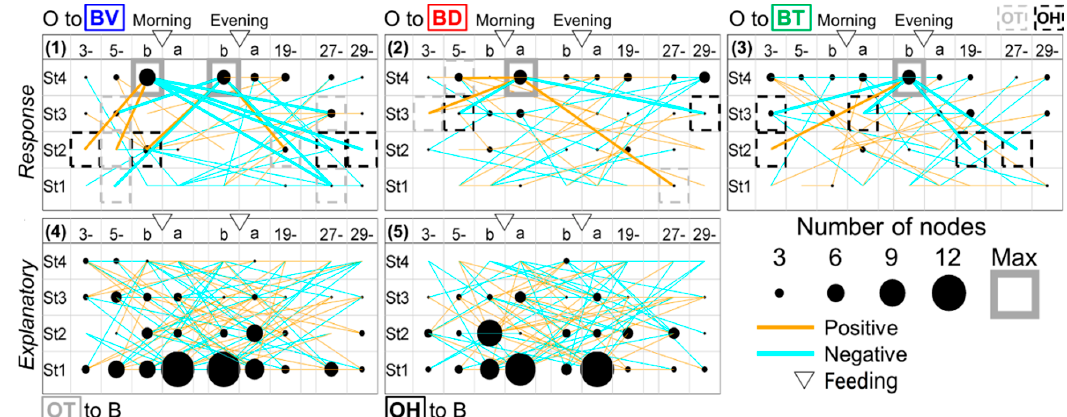
Figure 11. The number of nodes as explanatory or response in each time-point specifically in “feeding”. The numbers of explanatory or response variables (“nodes”) in each time-point are shown as the size of a filled circle, which can estimate the effects of the variables. The effects as response and explanatory are estimated by the regression of each B-variable on arbitrary O-indices ( 1 – 3 ), and the regression of arbitrary B-indices on each O-variable ( 4 , 5 ), respectively. The MRNs and MENs are marked by gray squares.